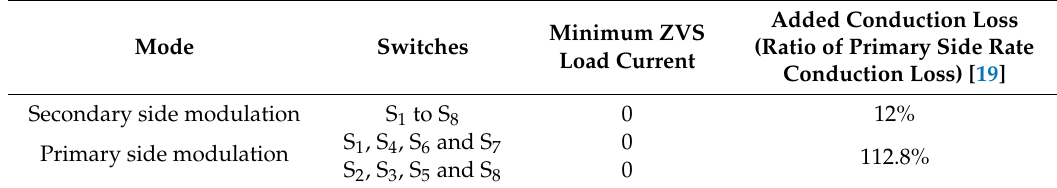
Table 4. Zero-voltage switching (ZVS) load range of the secondary and primary side modulation (I m = 60%I p, rate